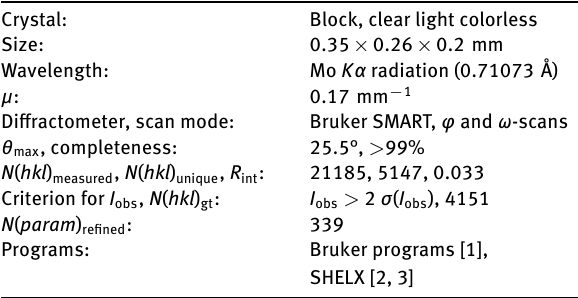
Table 2: Fractional atomic coordinates and isotropic or